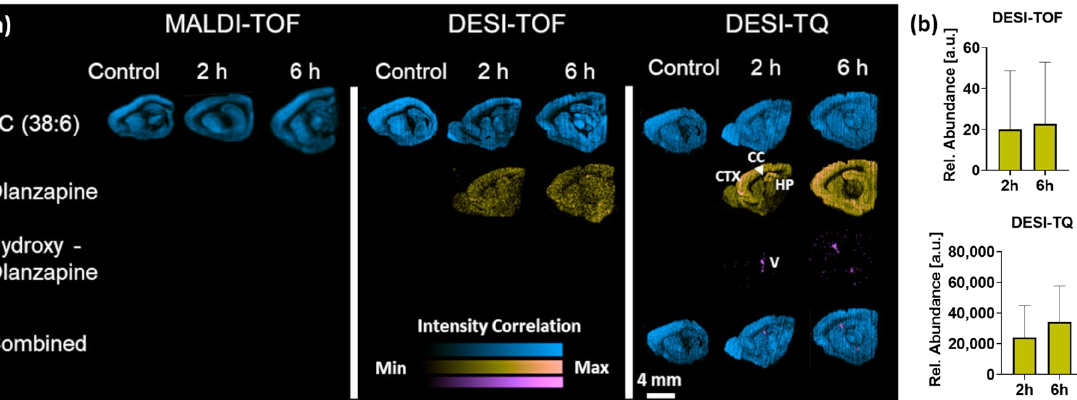
Figure 3. ( a ) Distribution of endogenous lipid PC(38:6), olanzapine, and its metabolite hydroxy- olanzapine in sagittal rat brain sections collected 2 and 6 h post dosing compared to a vehicle control. Distributions were determined by MALDI and DESI-MSI. DESI-MSI experiments were performed on a standard Q-TOF or a TQ-setup. All data were acquired with a spatial resolution of 50 µ m CTX = frontal cortex, CC = corpus callosum, HP = hippocampus, V = ventricle. ( b ) Relative abundances of olanzapine as detected by the different instruments. Data presented as mean ±